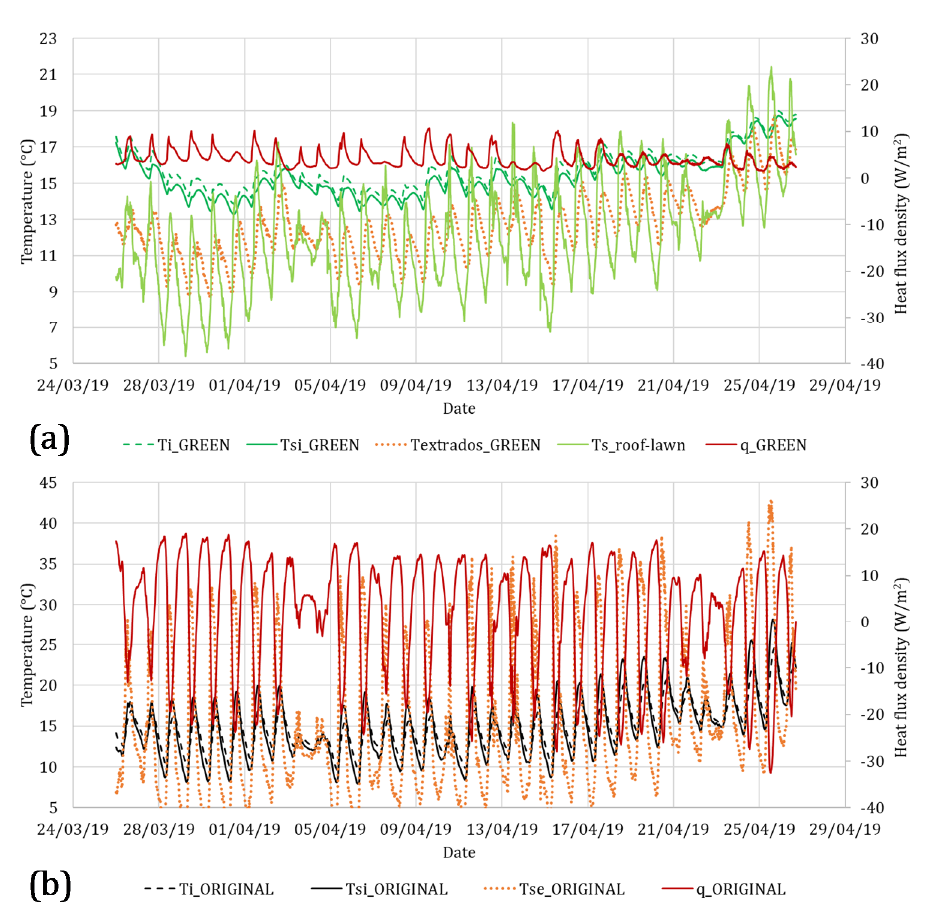
Figure 7. Heat fluxes, indoor temperatures and internal surface temperatures registered during middle season for the green roof ( a ) and the original one ( b ).